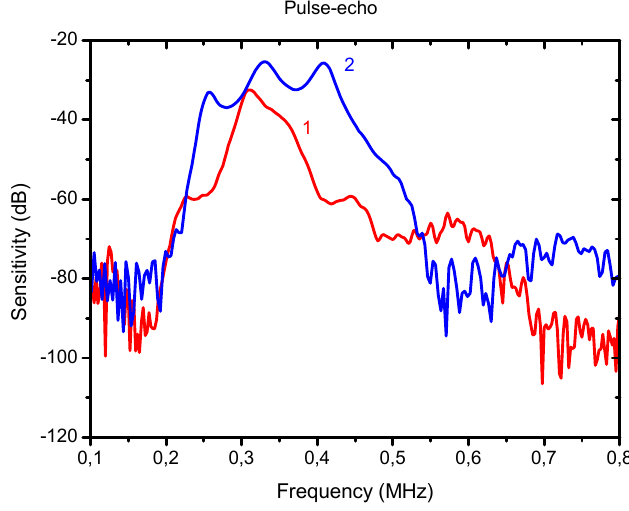
Figure 17. Sensitivity in pulse-echo mode of operation wideband excitation (spike). 1. (Red) Air-coupled transducer with active matching layer. 2. (Blue) Conventional air-coupled transducer with passive matching